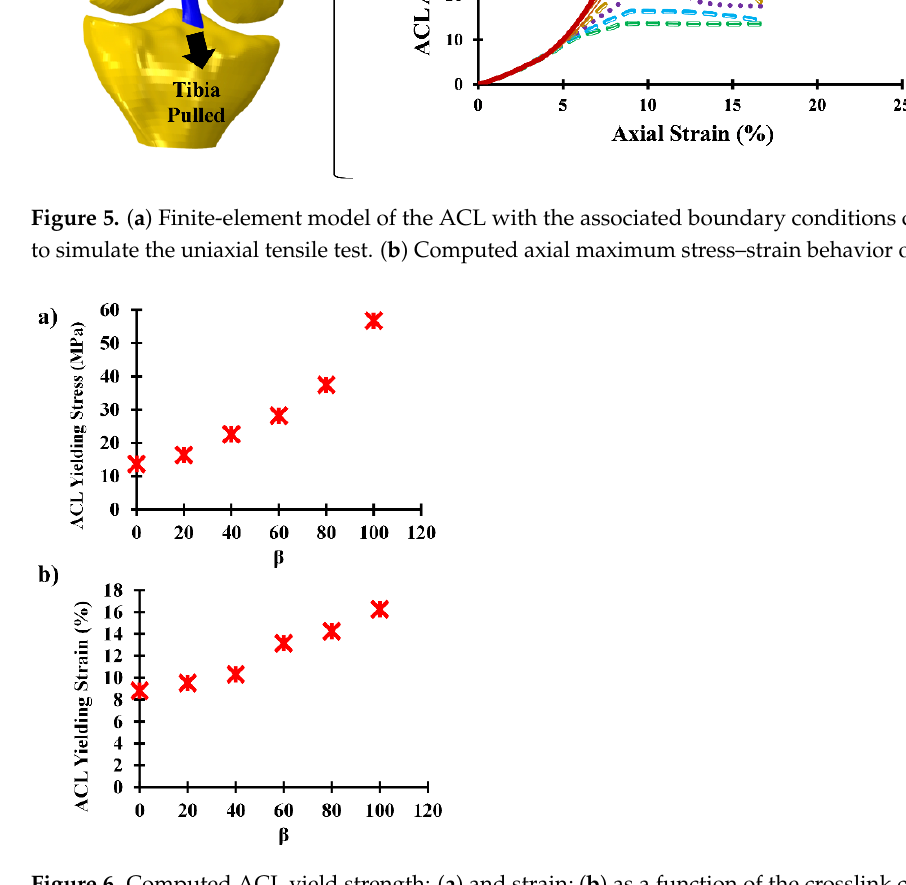
Figure 6. Computed ACL yield strength: ( a ) and strain; ( b ) as a functio n of the crosslink content (β).